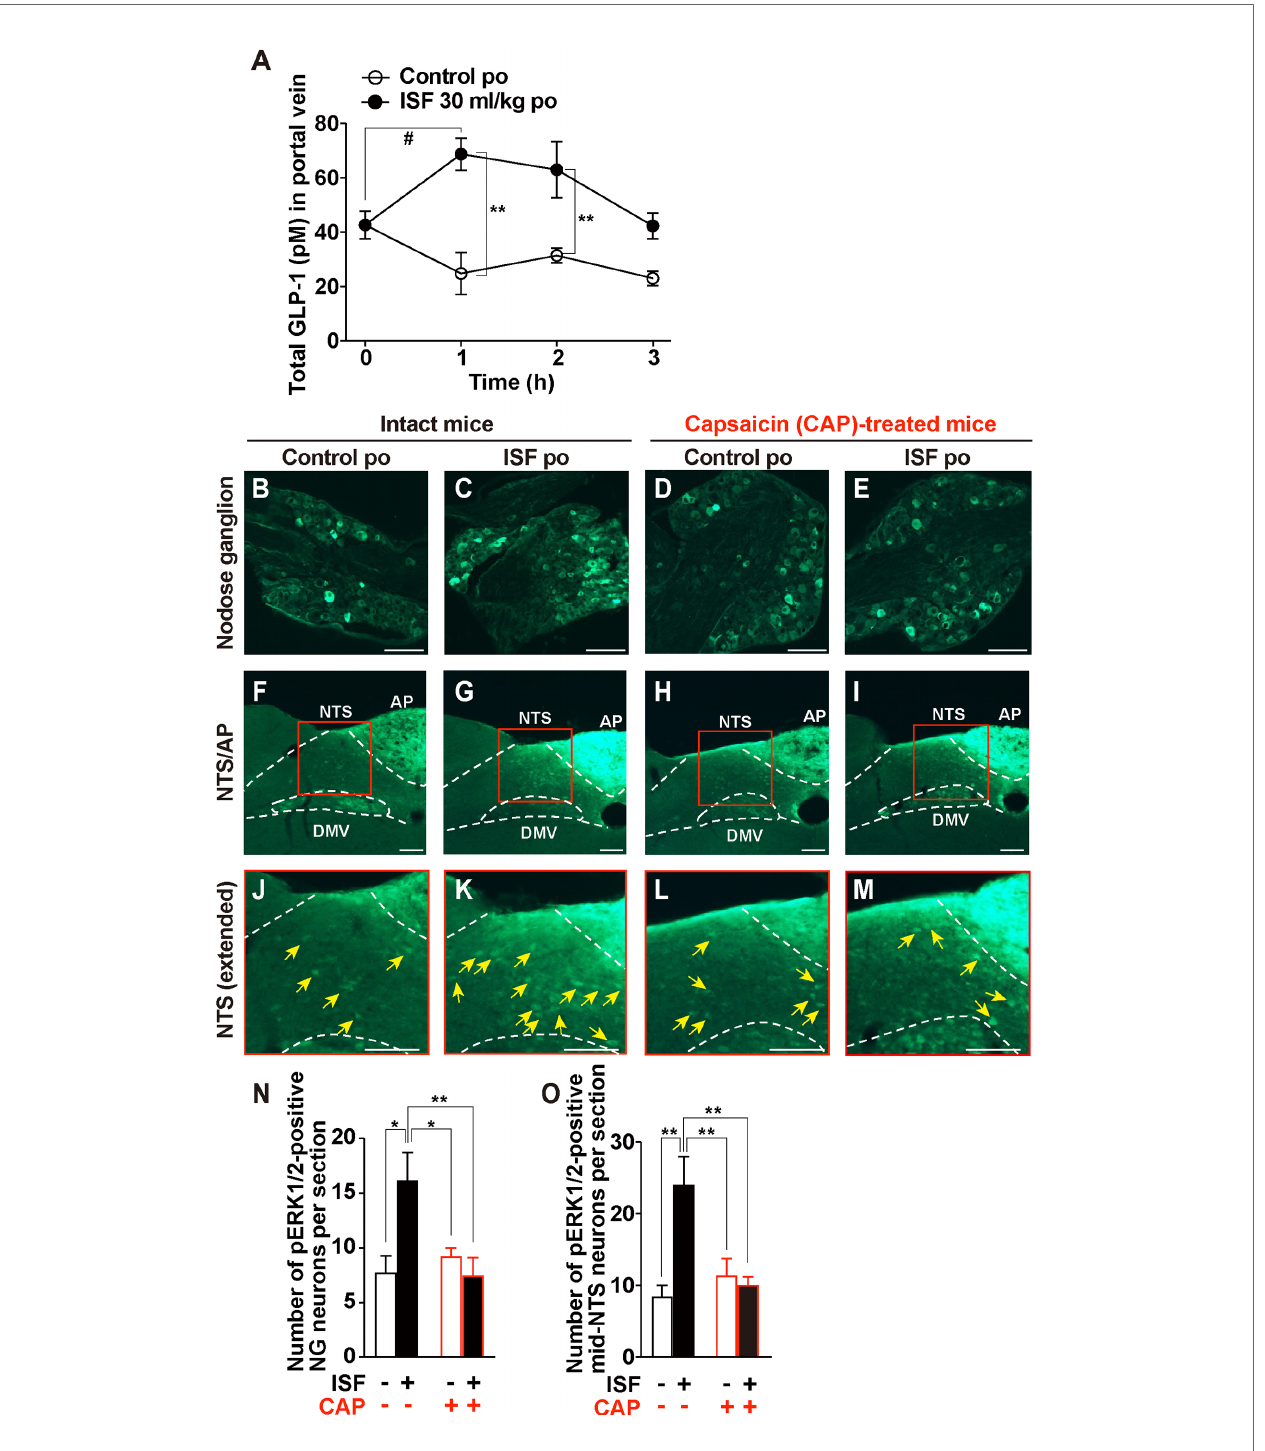
FIGURE 2 | ISF promotes GLP-1 secretion and activates the nodose ganglion (NG) and the nucleus tractus solitarius (NTS) via capsaicin-sensitive sensory nerves. (A) Time course of total GLP-1 concentrations in portal vein plasma after po administration of 30 ml/kg ISF or control solution. n = 7. ** p < 0.01 by two-way ANOVA followed by Bonferroni ’ s test vs . control. # p < 0.05 by two-way ANOVA followed by Dunnett ’ s test vs. 0 min. (B – I) NG (B – E) and NTS (F – M) sections immunostained for pERK1/2 at 30 min after po administration of 30 ml/kg ISF or control solution in control and systemic capsaicin (CAP)-treated mice. (J – M) Extended pictures of red squares in (F – I) , respectively. Arrowhead indicates pERK1/2-positive neurons. Scale bar, 100 µm. (N, O) Number of pERK1/2-positive neurons in the NG (N) and in the medial NTS (O) . CAP( − ); intact mice. CAP(+); CAP-treated mice. n = 5 – 6. * p < 0.05 and ** p < 0.01 by one-way ANOVA followed by Tukey ’ s test. Data show means ±